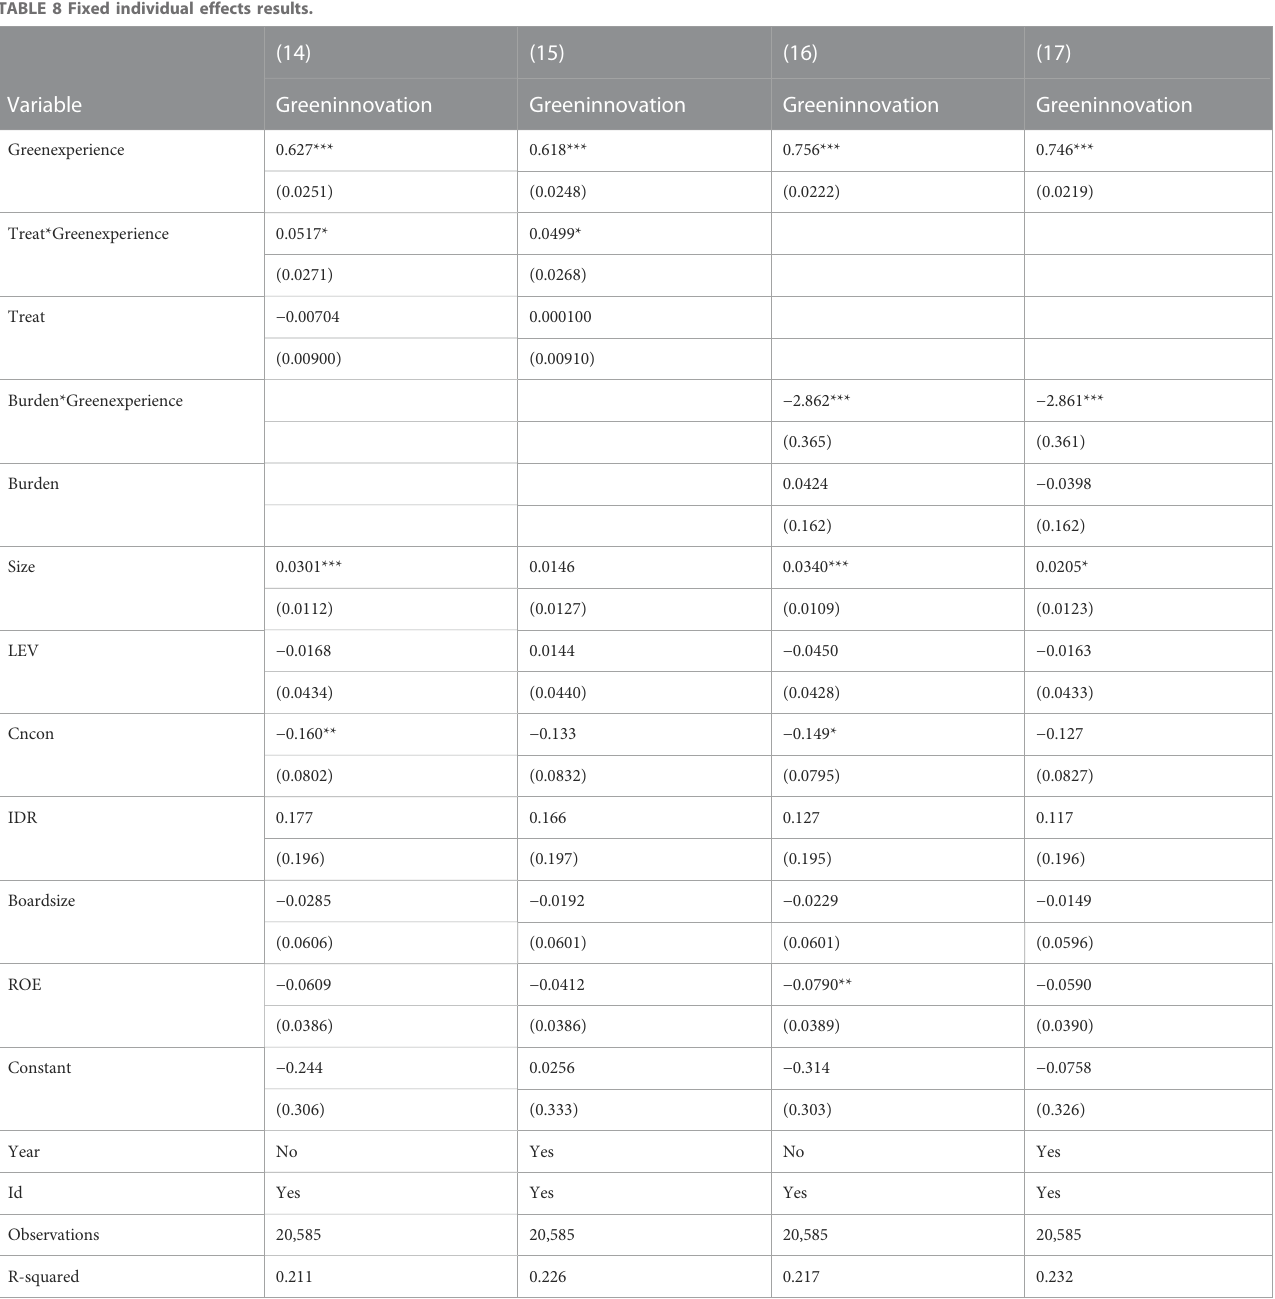
TABLE 8 Fixed individual effects